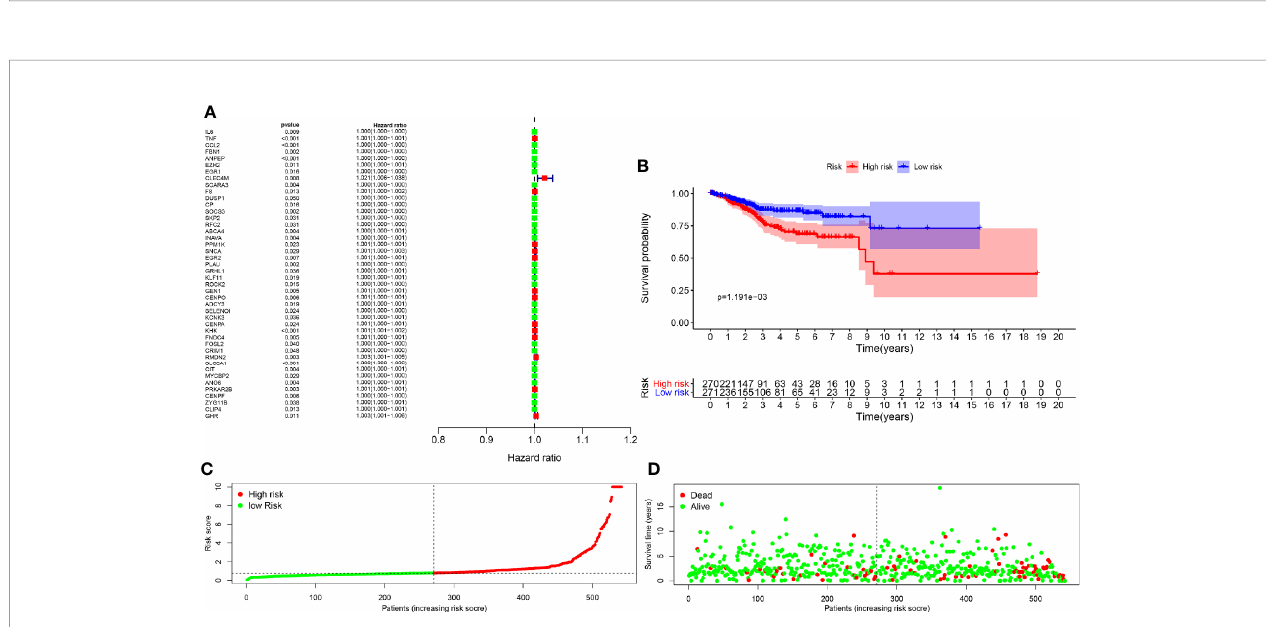
FIGURE 1 | Screening of mutual genes between UCEC and COVID-19. (A) , candidate, mutual genes of UCEC and COVID-19 in a Venn diagram. (B) , differentially expressed genes from mutual genes shown in a volcano-plot map.